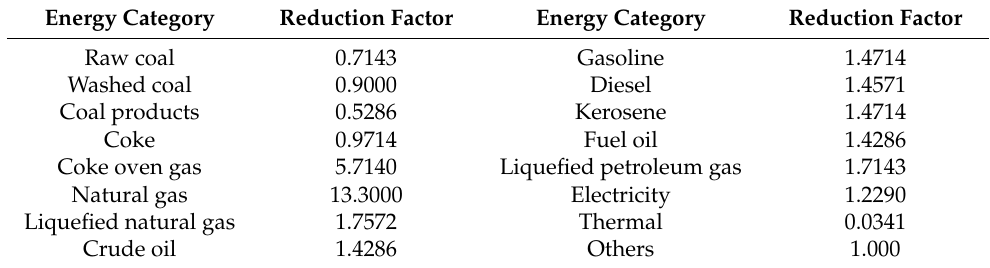
Table 1. Reduction coefficients of major energy categories in the energy industry